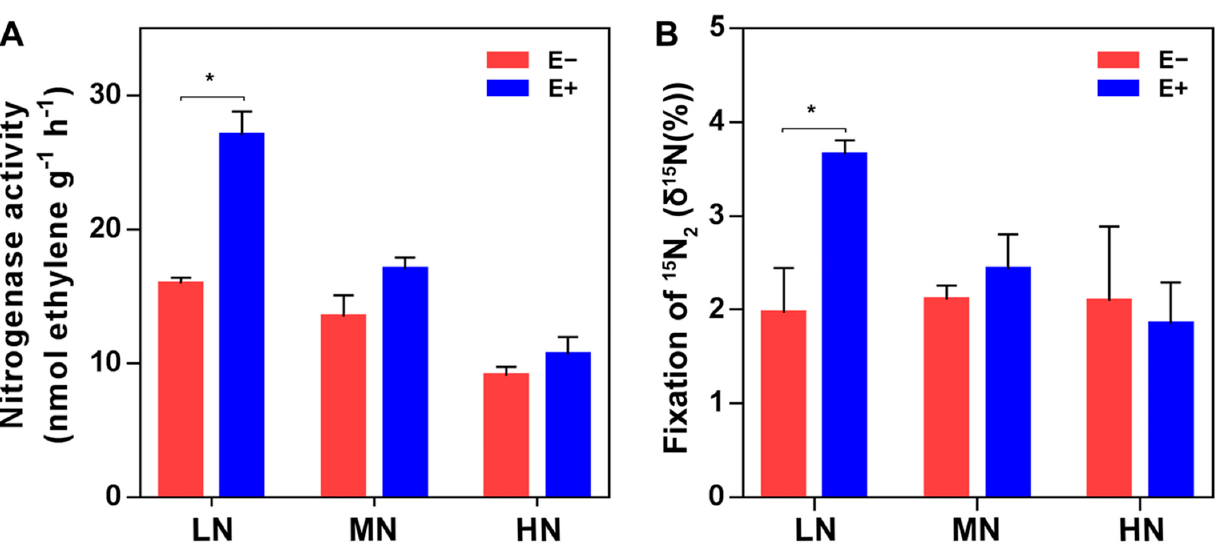
Figure 11. The nitrogen-fixing ability of maize rhizosphere soil. Nitrogenase activity was determined with an acetylene reduction assay ( A ) and 15 N 2 incorporation assay ( B ). The values are given as the means of three independent biological replicates. The asterisk (*) indicate significant differences between the inoculated (E+) and non-inoculated (E − ) groups, determined by Student’s t at p < 0.05.